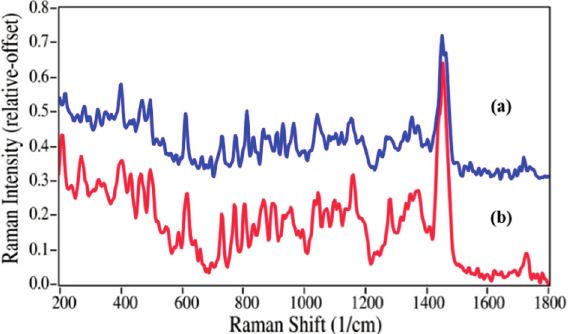
Figure 5. Raman spectra of ( a ) azithromycin and ( b ) azaerythromycin A. Spectral conditions as in Figure